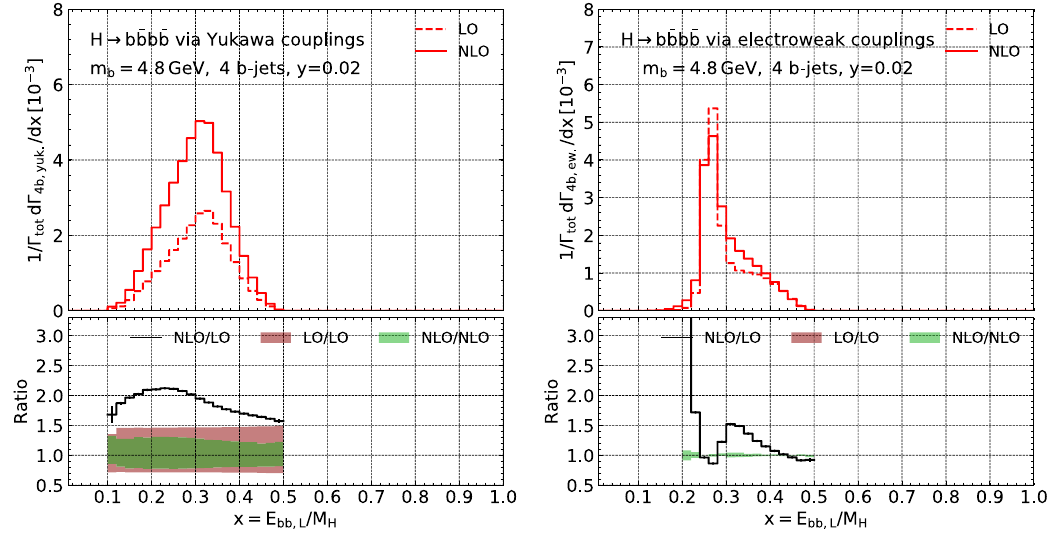
Figure 16 . Similar to figure 7 for distribution as a function of the lowest energy of all b -jet pairs.